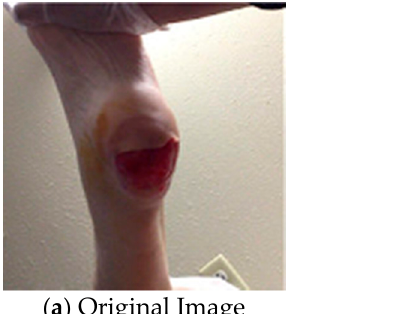
Figure 11. The probabilities of wound types: Pressure injury: 27.3%, lymphovascular: 12%, surgical: